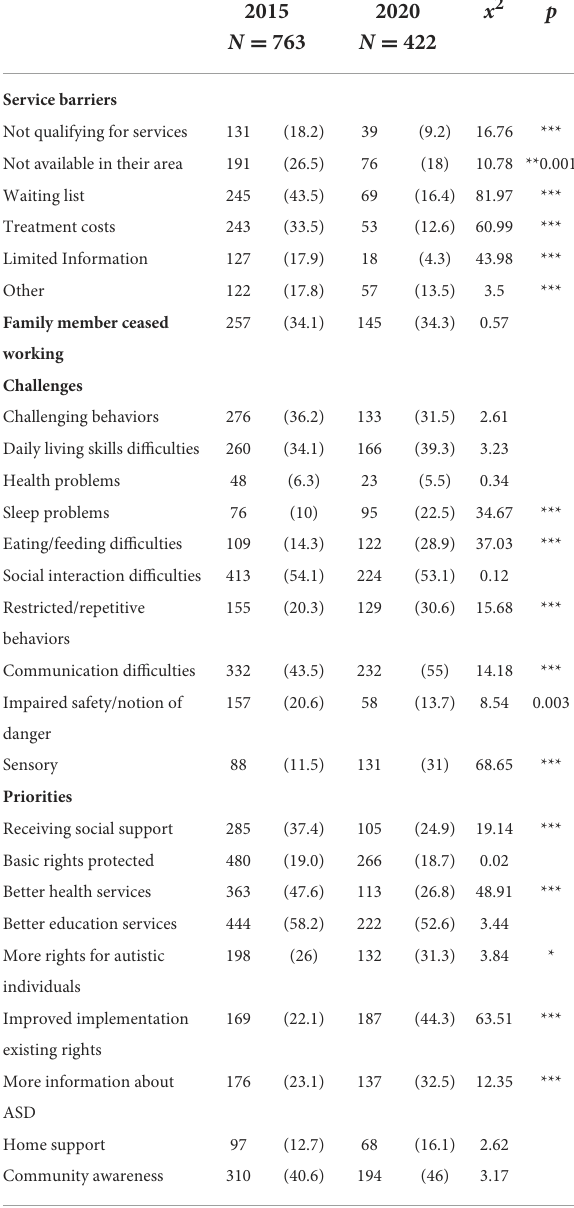
TABLE 6 Service barriers, challenges, and